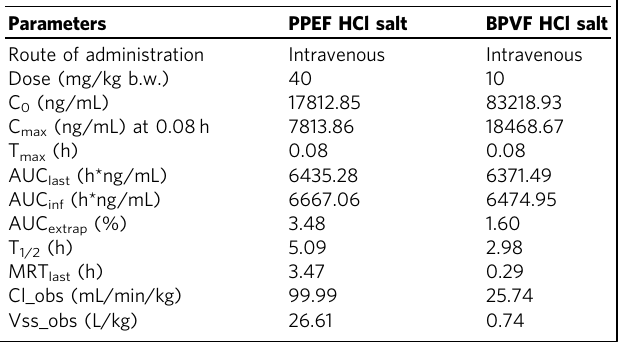
Table 2 Single-dose intravenous pharmacokinetics study of PPEF and BPVF HCl salt in male BALB/c mice. Mean plasma PK parameters Parameters